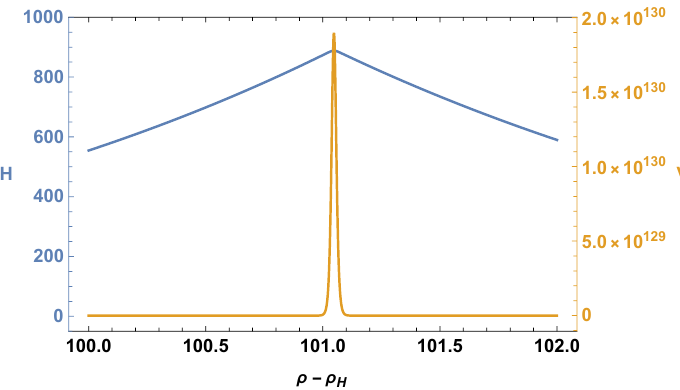
Figure 3: The potential V ( φ ( ρ )) (right axis, orange) and H ( φ ( ρ )) = V ′ / V (left axis, blue) close to one of the transitions between Kasner epochs shown in Fig. 1. The potential varies much more abruptly than H . This leads to a narrow as well as an extended bounce